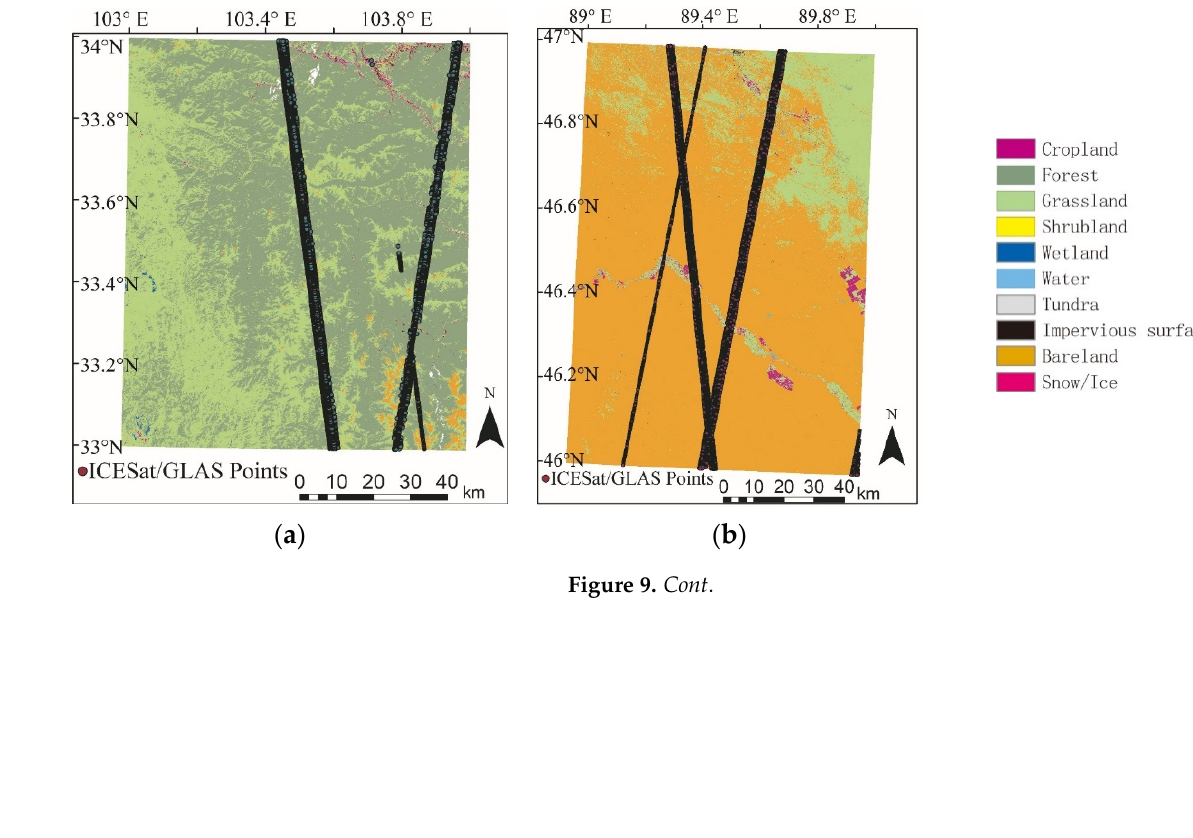
Figure 8. The relationship between quality indicators ((left) MAD and (right) LE90) and aspects in four study areas: ( a ) Sichuan; ( b ) Xinjiang A; ( c ) Xinjiang B; and ( d ) Inner Mongolia.